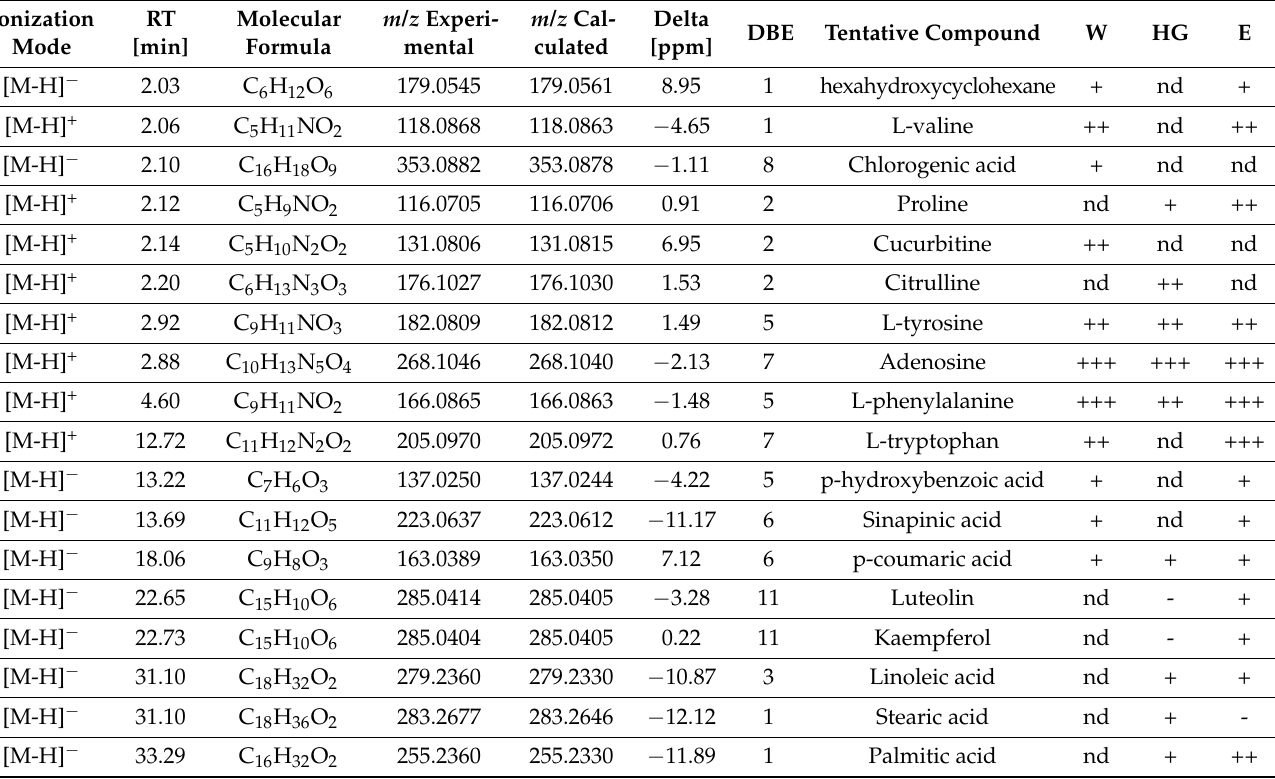
Table 6. The tentatively identified compounds in C. moschata ‘Muscat’ peel